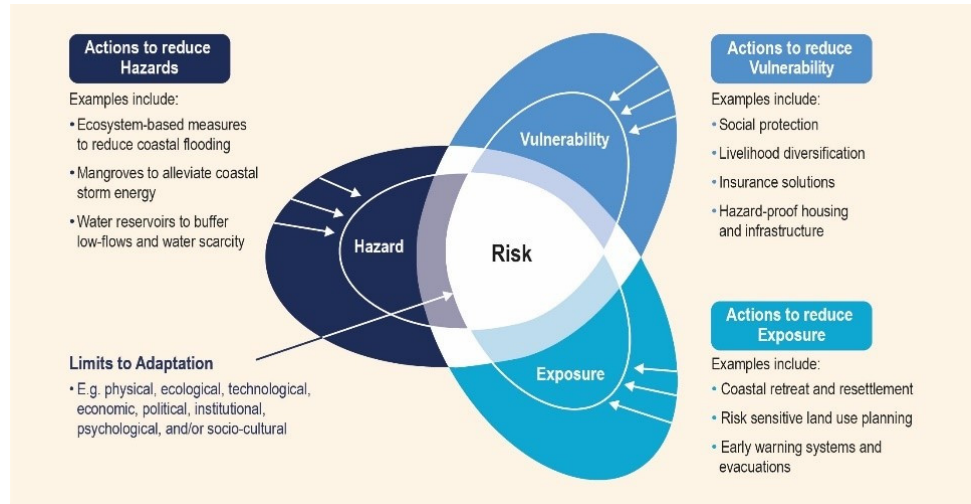
Figure 3. The framing of IPCC links hazard–vulnerability–exposure directly to solutions, and thus promotes single-issue incremental adaptation approaches over transformative solutions. Source: (Abram et al. 2019).